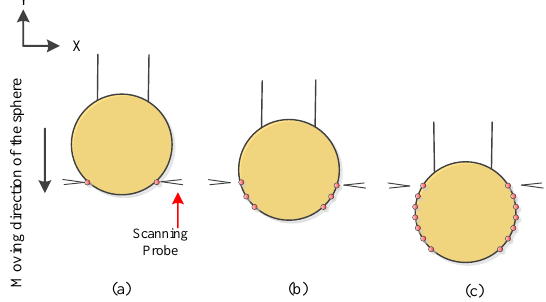
Figure 2. Measurement of a maximal cross section profile circle: ( a ) Initial measurement position; ( b ) Measurement process; ( c ) A circle measurement is finished.